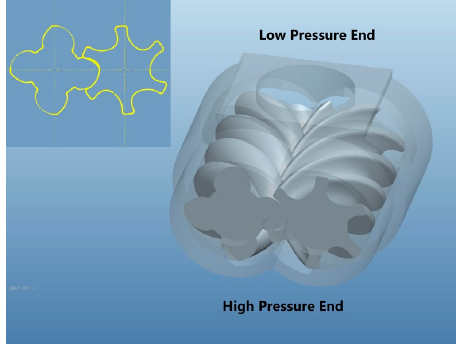
Figure 3. 3D geometry model and rotor profile. Table 1. Geometric parameters of twin screw expander.